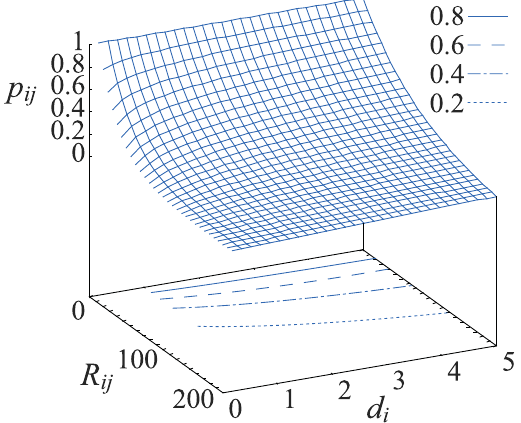
Figure 1. The probability of edge emergence, p ij , as a function of the Euclidean distance between nodes i and j ( R ij ) and of the degree of node i ( d i ). Several iso-probability lines are shown by contour lines on the lower surface (see legend). The parameters are here set to λ = 0.02 and β =